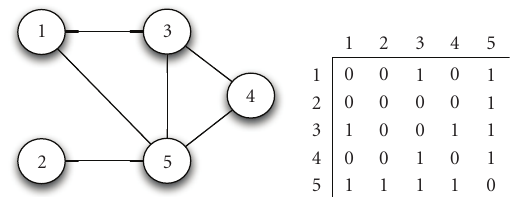
Figure 2: Mathematical network with undirected edges, represent- ing the structure of the trophic web in Figure 1, pictorially and as an equivalent adjacency matrix. The connectivity of the nodes is one for node 2, two for nodes 1 and 4, three for node 3, and four for node 5 (which is a hub node).